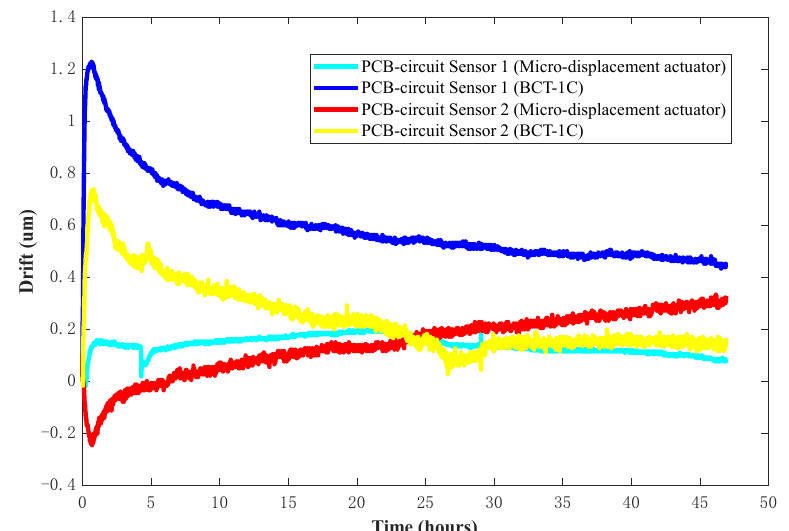
Figure 10. Test results of time drift stability with different fixtures within 48 h after installation.